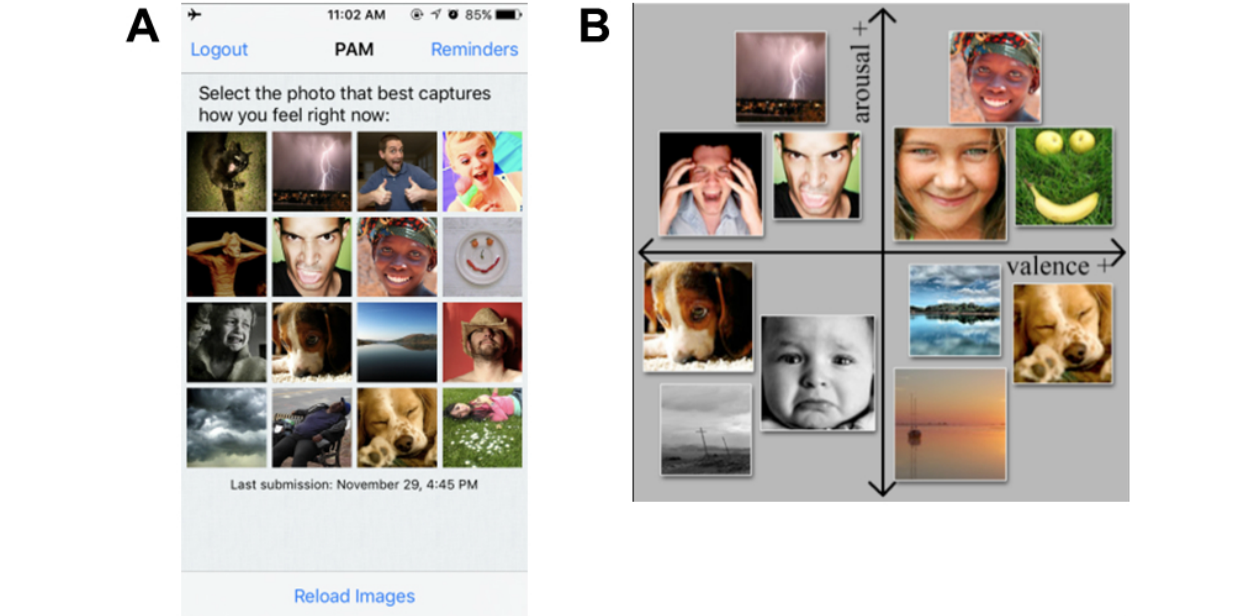
Figure 3. The Photographic Affect Meter (PAM) app. (A) Screenshot of the PAM visual interface, and (B) how images are arranged from low arousal and negative valence in the bottom left to high arousal and positive valence in the top